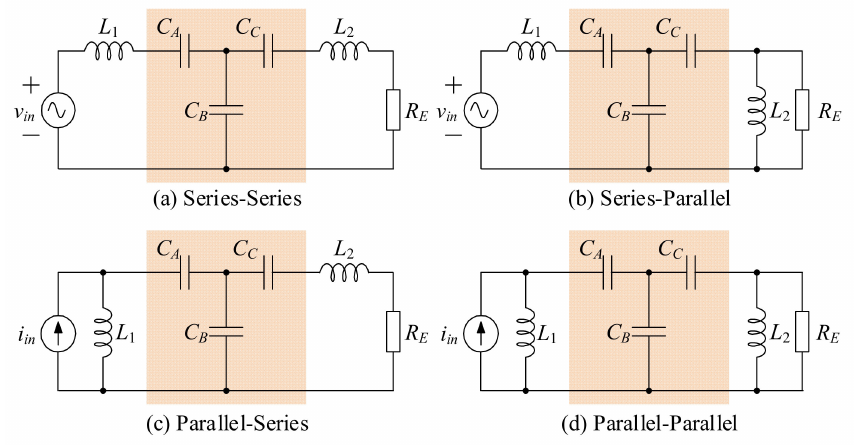
Figure 4. Four basic capacitive power transfer (CPT) circuits.